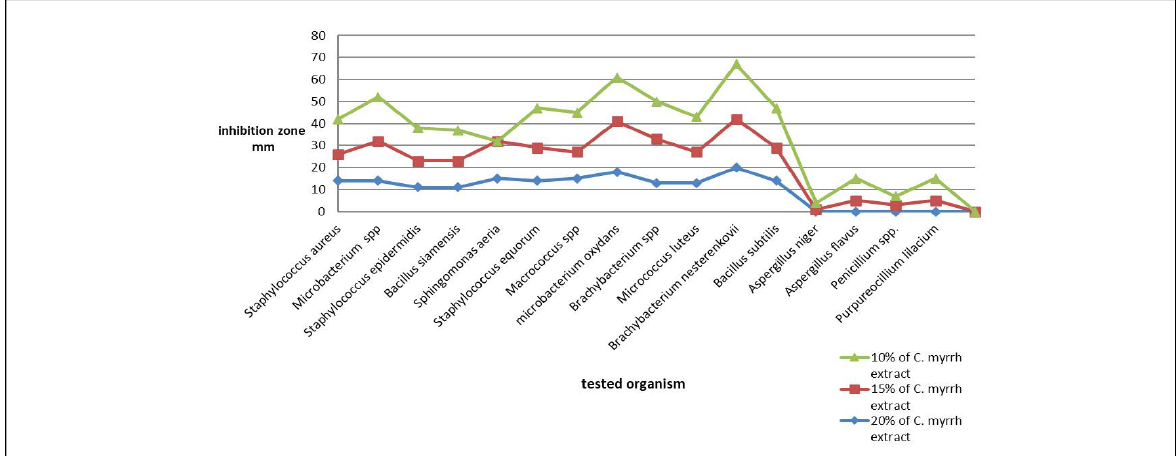
Figure 2: The means of the three concentrations of C. myrrh